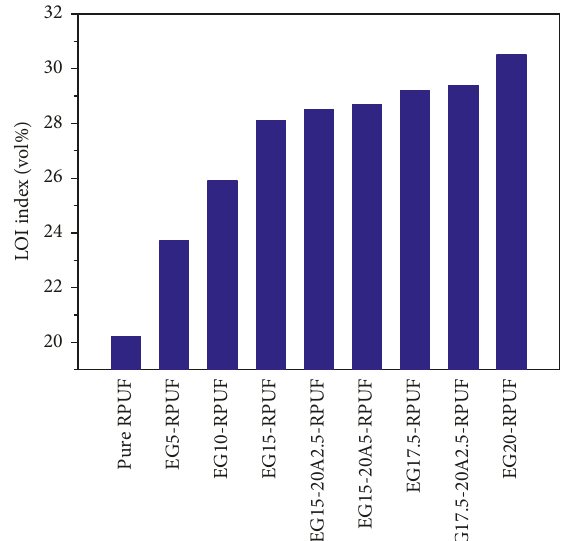
Figure 2: LOI values of the PU foams using different flame-retardant